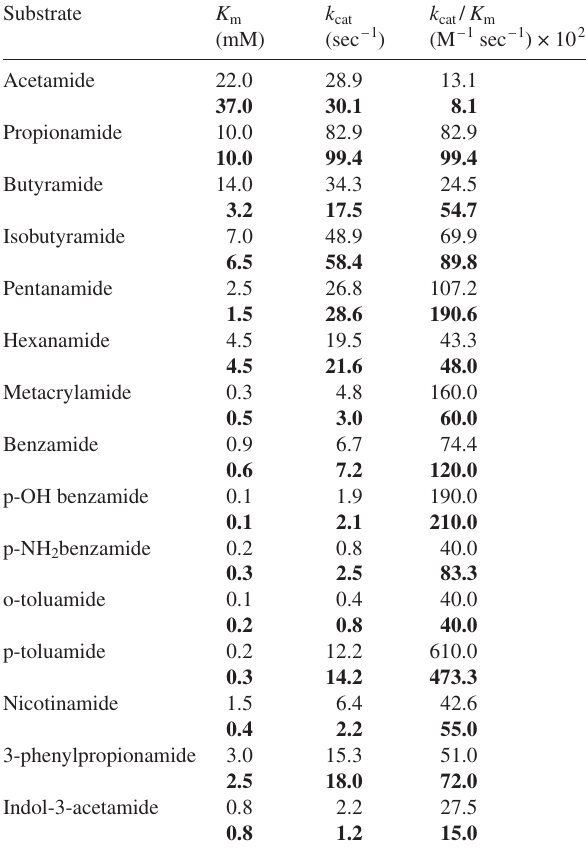
Y41C mutant (in bold). The turnover number ( k cat ) was obtained di- viding by the molecular mass of the active monomer (55,784 Da); temperature was 70 °C; there were 1–10 µg of enzyme in a total vol- ume of 200 µl incubated for 2–10 min in 50 mM citrate buffer at pH 5.0. Abbreviation: K m = Michaelis